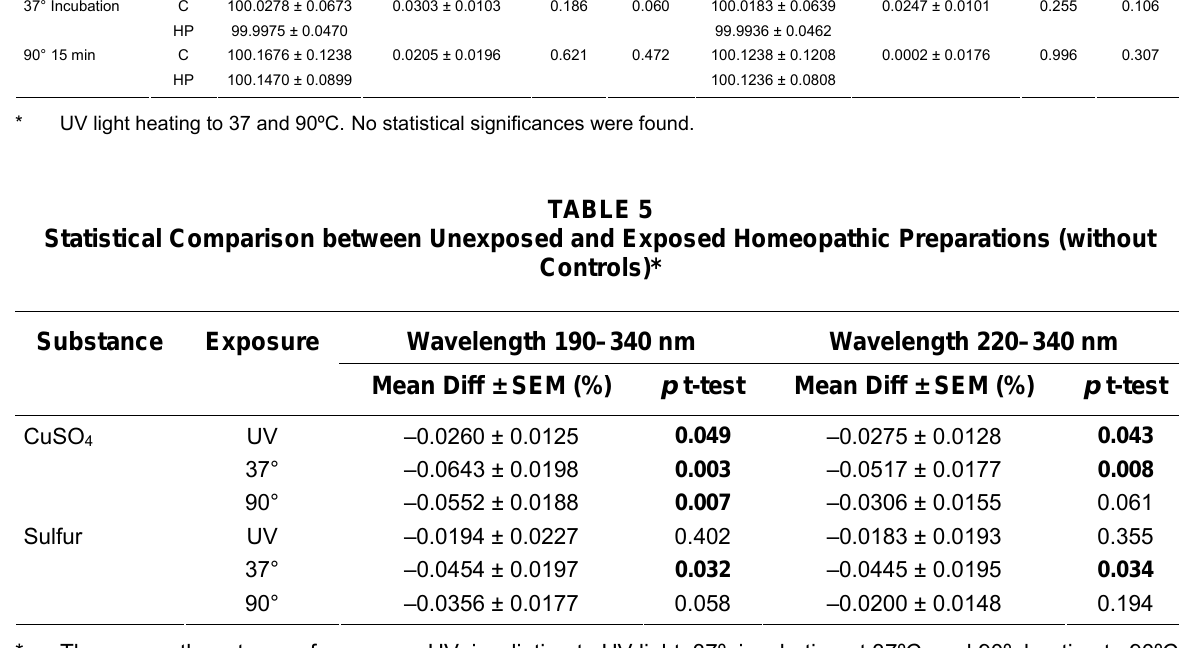
Results of the Different Measurements of S